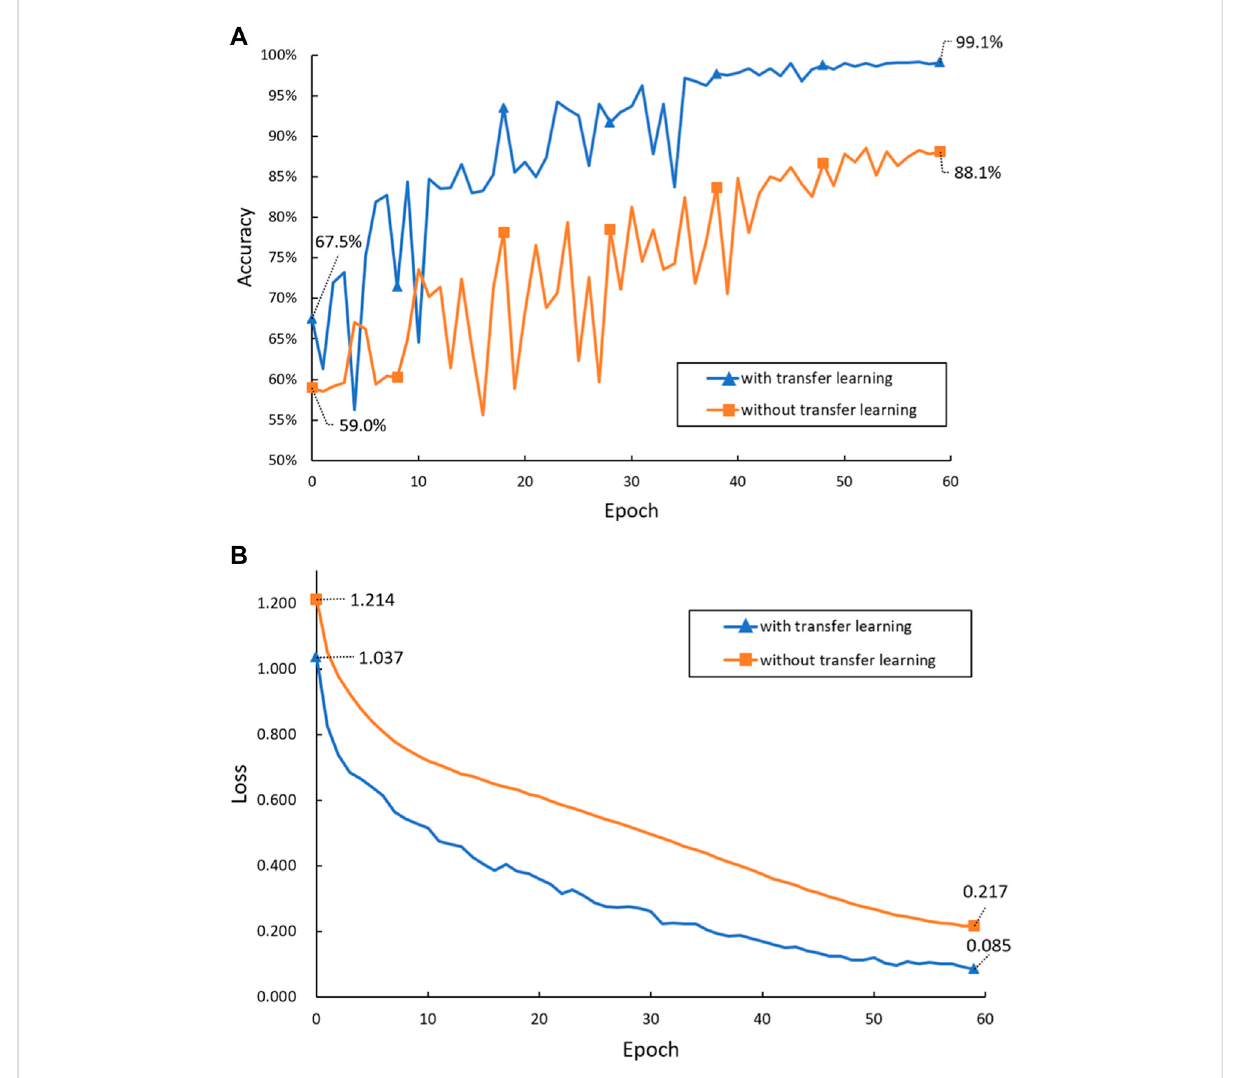
FIGURE 10 The accuracy (A) and the loss (B) values of the models over different